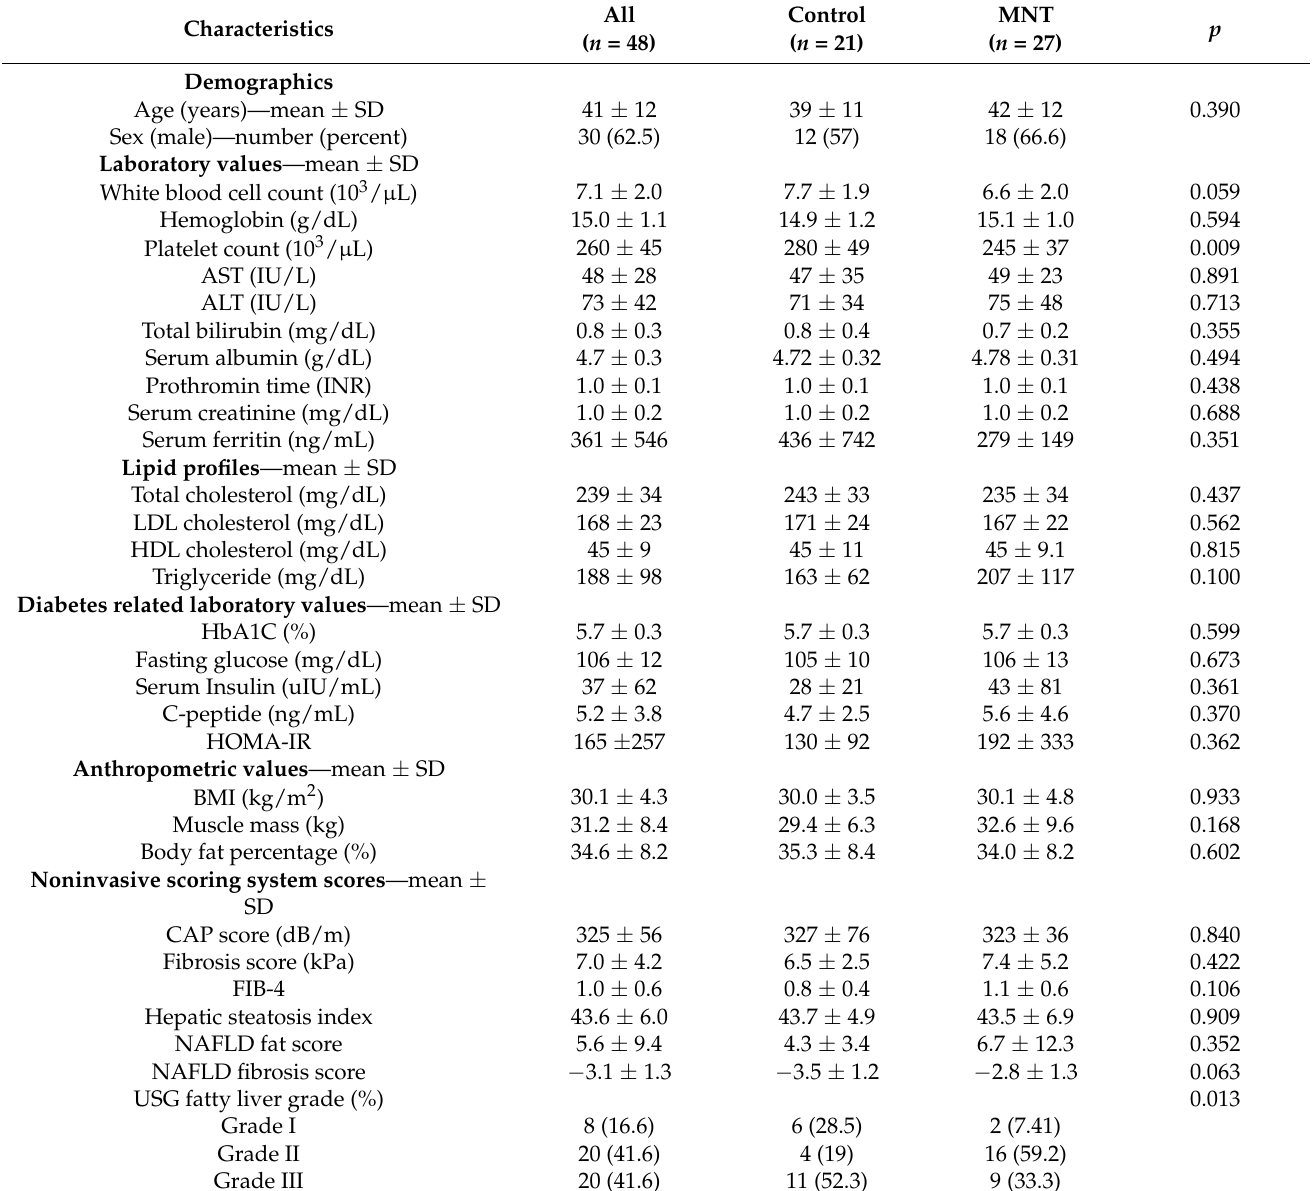
Table 1. Baseline characteristics of